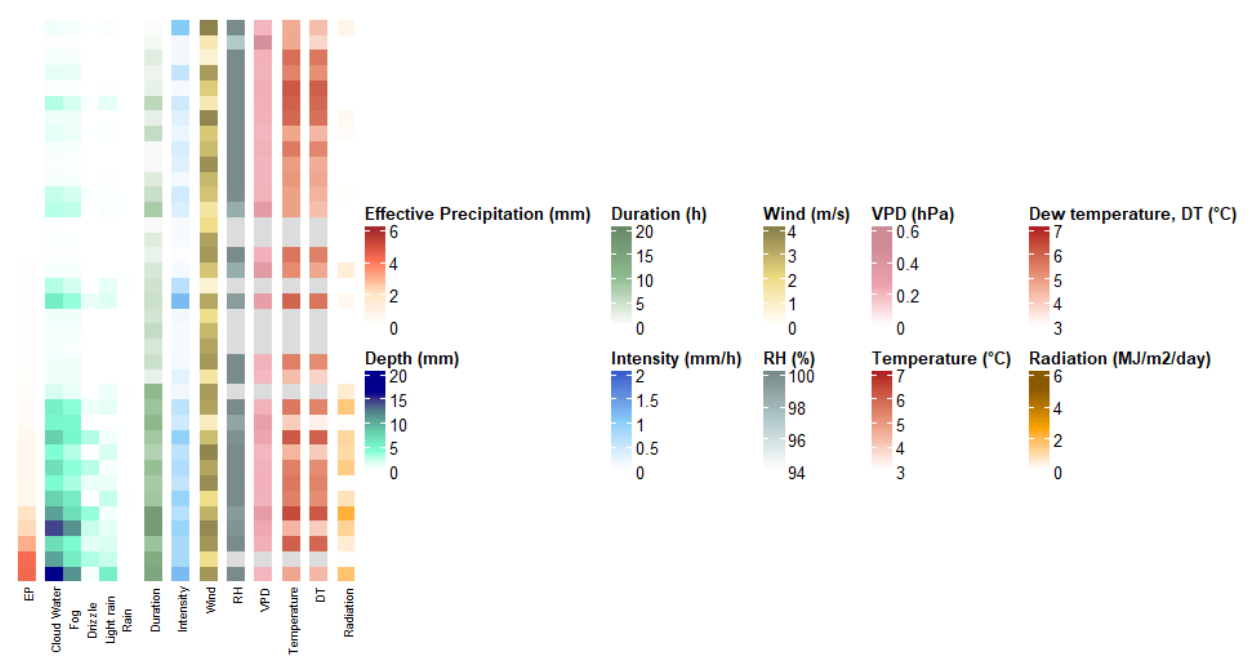
Figure A2. Heat-map for cloud-water events as they relate to effective precipitation, the event characteristics, and the meteorological variables (wind, relative humidity, vapor pressure deficit, temperature, dew temperature, and radiation) analyzed to find an influence on soil moisture gain. Each bar represents a CW event and they are organized by effective precipitation increasing values.